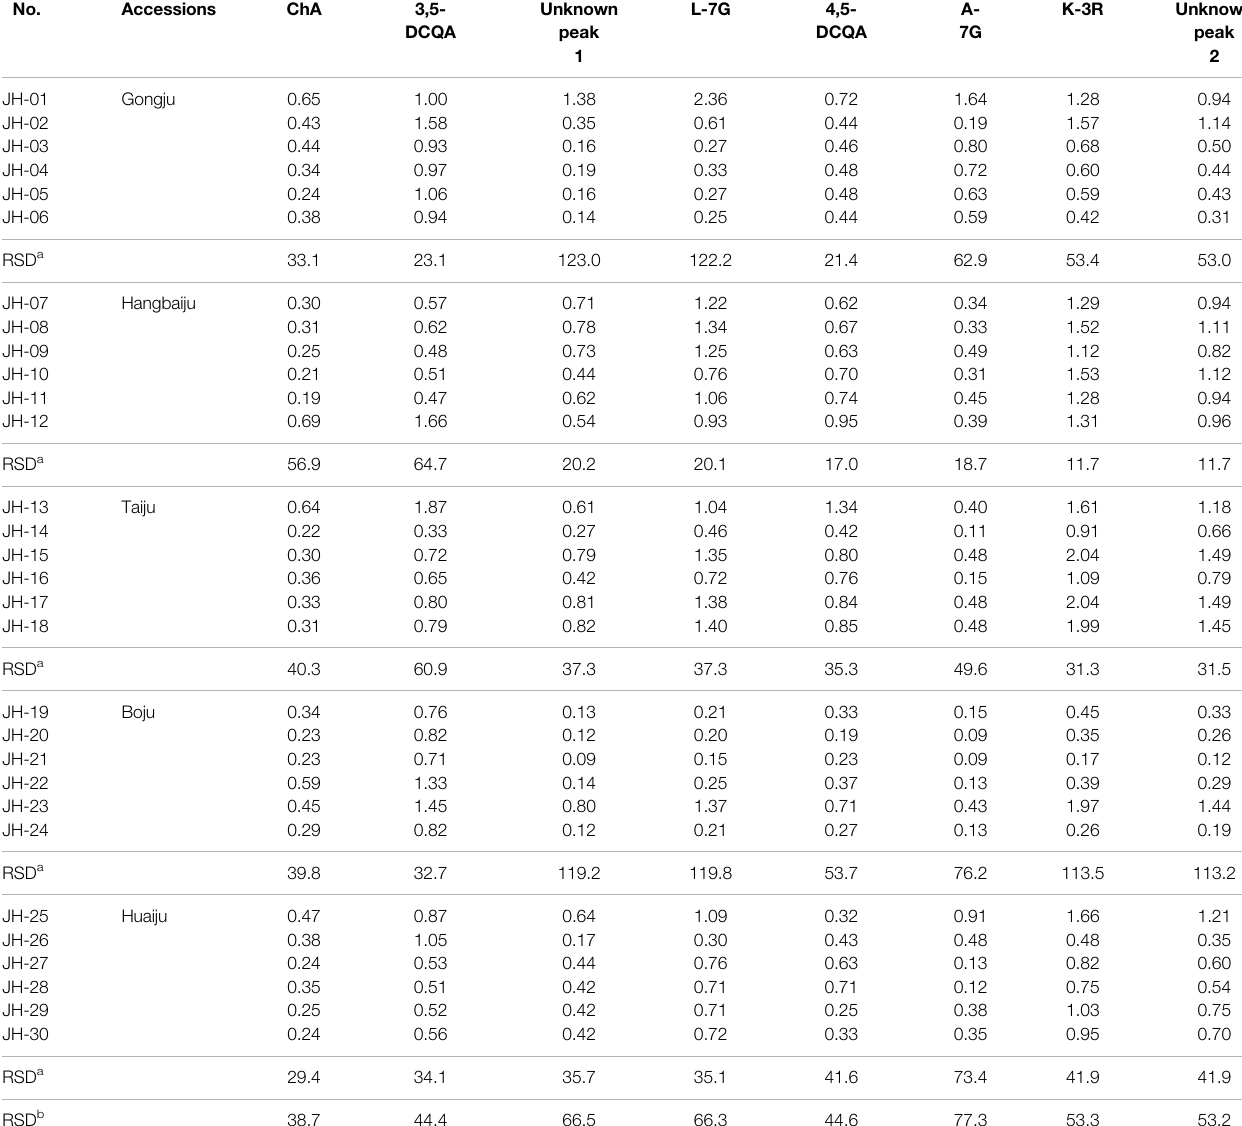
TABLE 5 | Contents of eight common peaks in 30 batches of CMs (%, g/g).